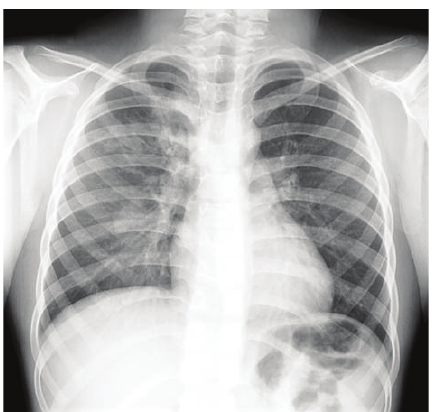
Figure 1: Initial chest X-ray: right upper and lower lobe infiltrations.